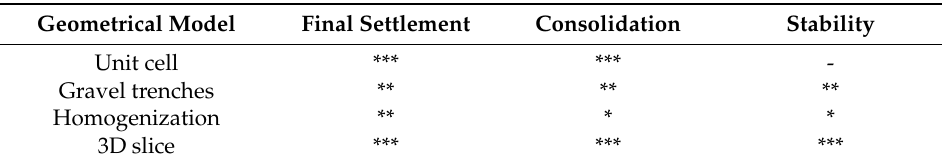
Table 1. Suitability of simplified geometrical models to study different features of a stone column treatment for the foundation of an embankment.